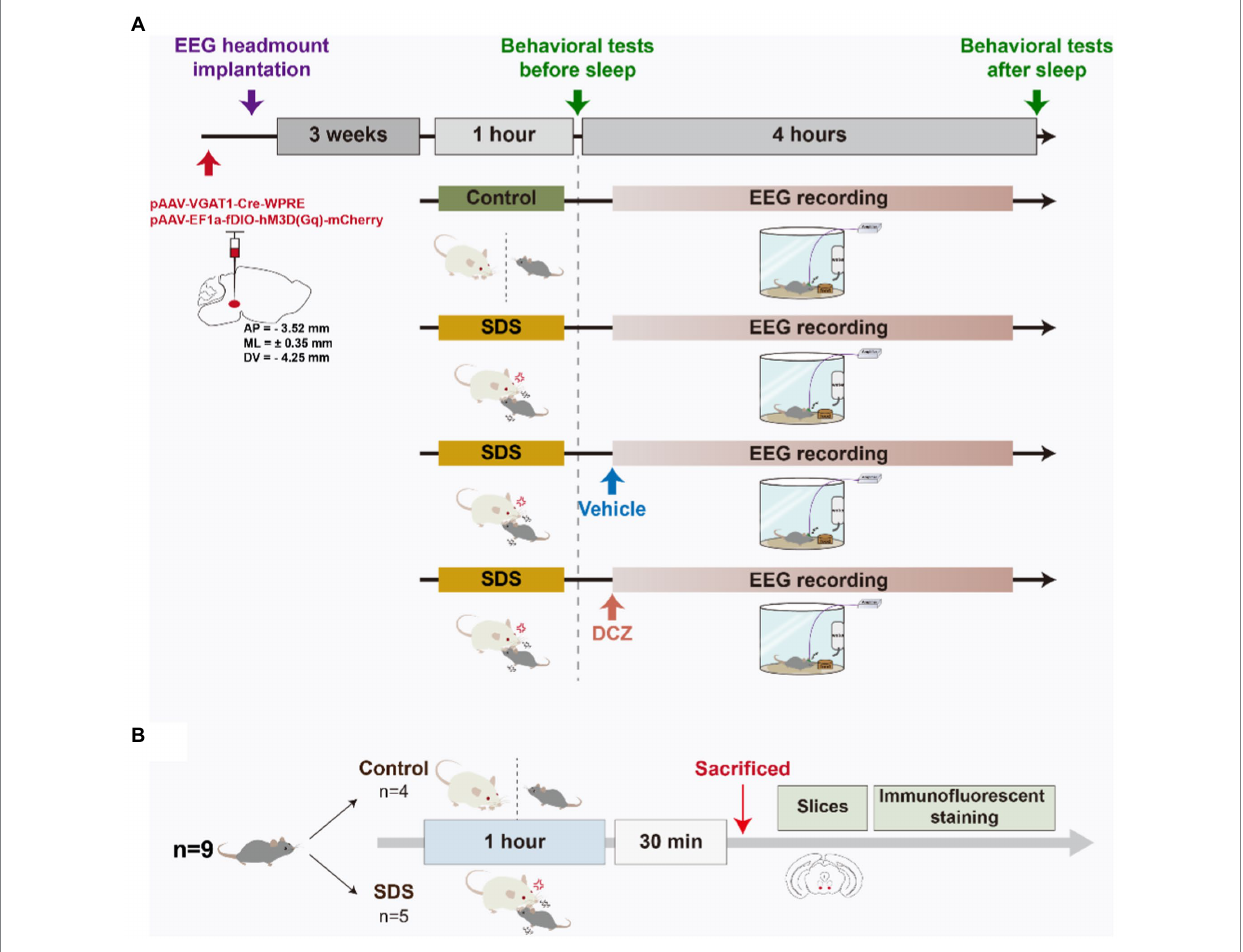
FIGURE 1 Schematic diagram of the experimental design. (A) APP/PS1 mice were stereotaxically injected with pAAV into the VTA, and EEG headmounts were implanted. After 3 weeks of acclimation, the mice randomly underwent four rounds, namely, non-SDS, SDS, SDS + VTA Vgat vehicle, or SDS + VTA Vgat activation. The open field test and elevated plus maze behavioral tests were performed before and after a 4-h EEG recording. Vehicle solution or DCZ was administered before EEG recording in the SDS + VTA Vgat vehicle or SDS + VTA Vgat activation groups, respectively. (B) After procedures in A, mice underwent SDS-control and SDS procedure respectively, and were sacrificed 30 min later for tissue